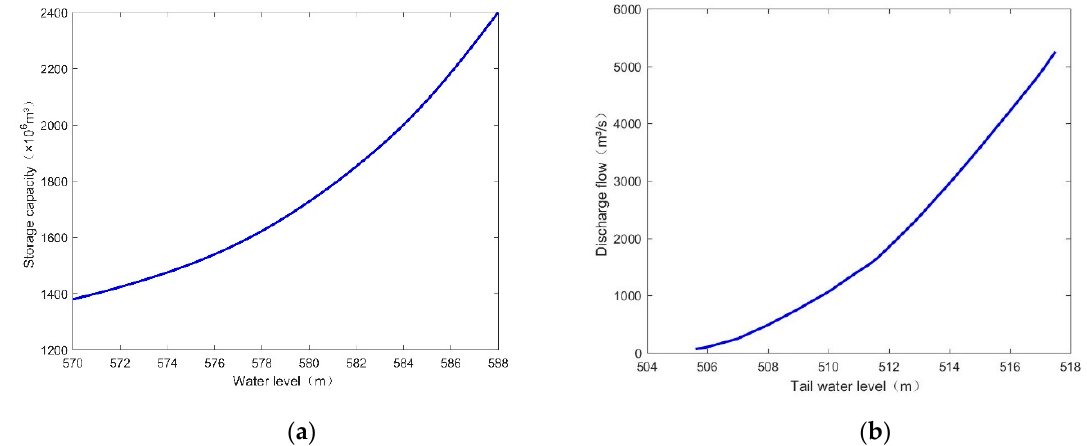
Figure 6. ( a ) Water level-storage capacity curve; ( b ) Discharge flow-water level curve. According to the wind power interval prediction model based on the Copula function established in the Ref [38], the interval prediction of the original wind power output is carried out. The confidence level is selected as 0.93. As the confidence level increases, the larger the interval coverage of the prediction result, the fewer the data points that are beyond the limit. It means that more actual values fall within the obtained wind power range. However, at the same time, the average width of the interval also increased, and the prediction result is conservative, which cannot provide more effective information for scheduling decision-making. Therefore, the confidence interval is 0.93. The result obtained is used as the wind power output data in the wind power and hydropower joint dispatching. The result is shown in Figure 7.